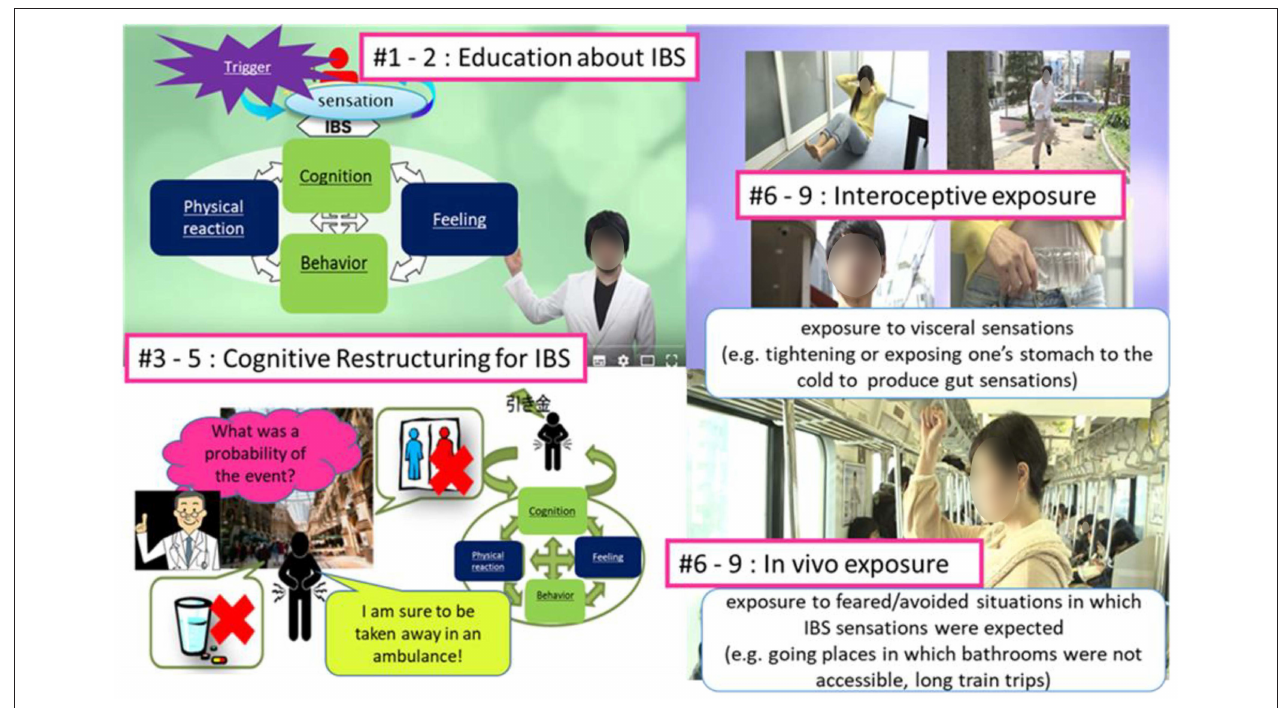
FIGURE 2 | Contents of psychoeducational